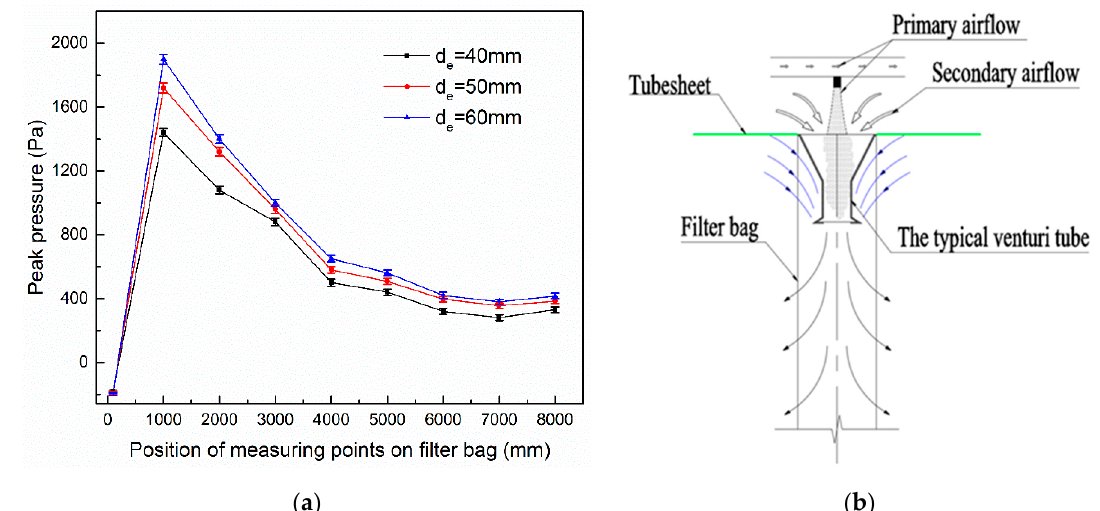
Figure 9. Effect of venturi throat diameter on the peak pressure of filter bag. ( a ) Plotted data indicates the peak pressure at each measuring point on the filter bags with different venturi throat diameters. ( b ) Schematic diagram showing the distribution of the cleaning pressure on a filter bag with the typical venturi-type tube.